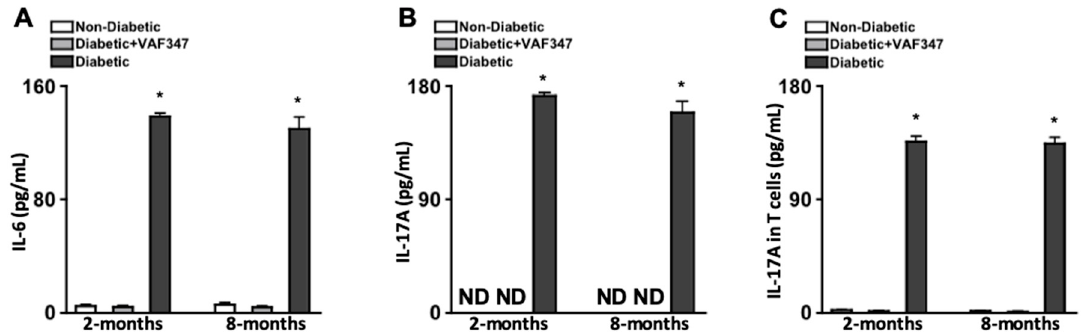
Figure 1. Levels of IL-6 and IL-17A in sera, and IL-17A in CD4 + T cells of STZ-diabetic mice. ELISA quantification of IL-6 ( A ) and IL-17A ( B ) in sera collected from non-diabetic (white, n = 5), VAF347-treated STZ-diabetic (grey, n = 5), and untreated STZ-diabetic (black, n = 5) C57BL/6 mice; two and eight months after diabetes was confirmed. ( C ) Quantification of IL-17A in protein lysates of CD4 + T cells isolated from spleens of non-diabetic (white), VAF347-treated STZ-diabetic (grey), and untreated STZ-diabetic (black) C57BL/6 mice two and eight months after diabetes was confirmed. * = p < 0.01 per two-way ANOVA and unpaired Student’s t -test. ND = not detected. Data are representative of two separate experiments with similar results.